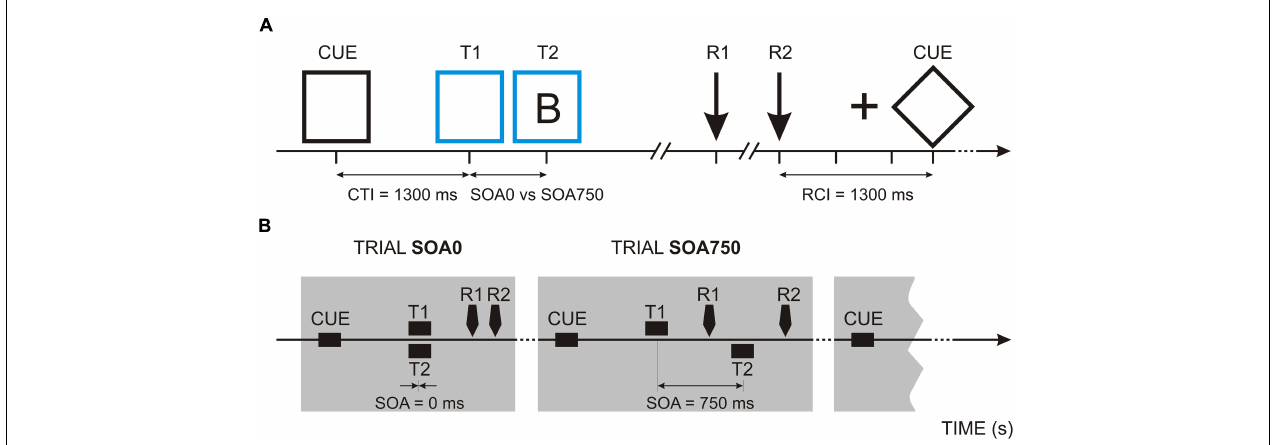
FIGURE 1 | Psychological refractory period (PRP) task: (A) Procedure of a single experimental trial. In the example, a blue frame and the letter B are presented as target stimuli. CTI, Cue-target interval; SOA, stimulus onset asynchrony; T1/R1, first target and reaction time in response to the first target; T2/R2, second target and reaction time in response to the second target; RCI, response-cue interval. (B) Trials with SOA = 0 ms and SOA = 750 ms. Response times are